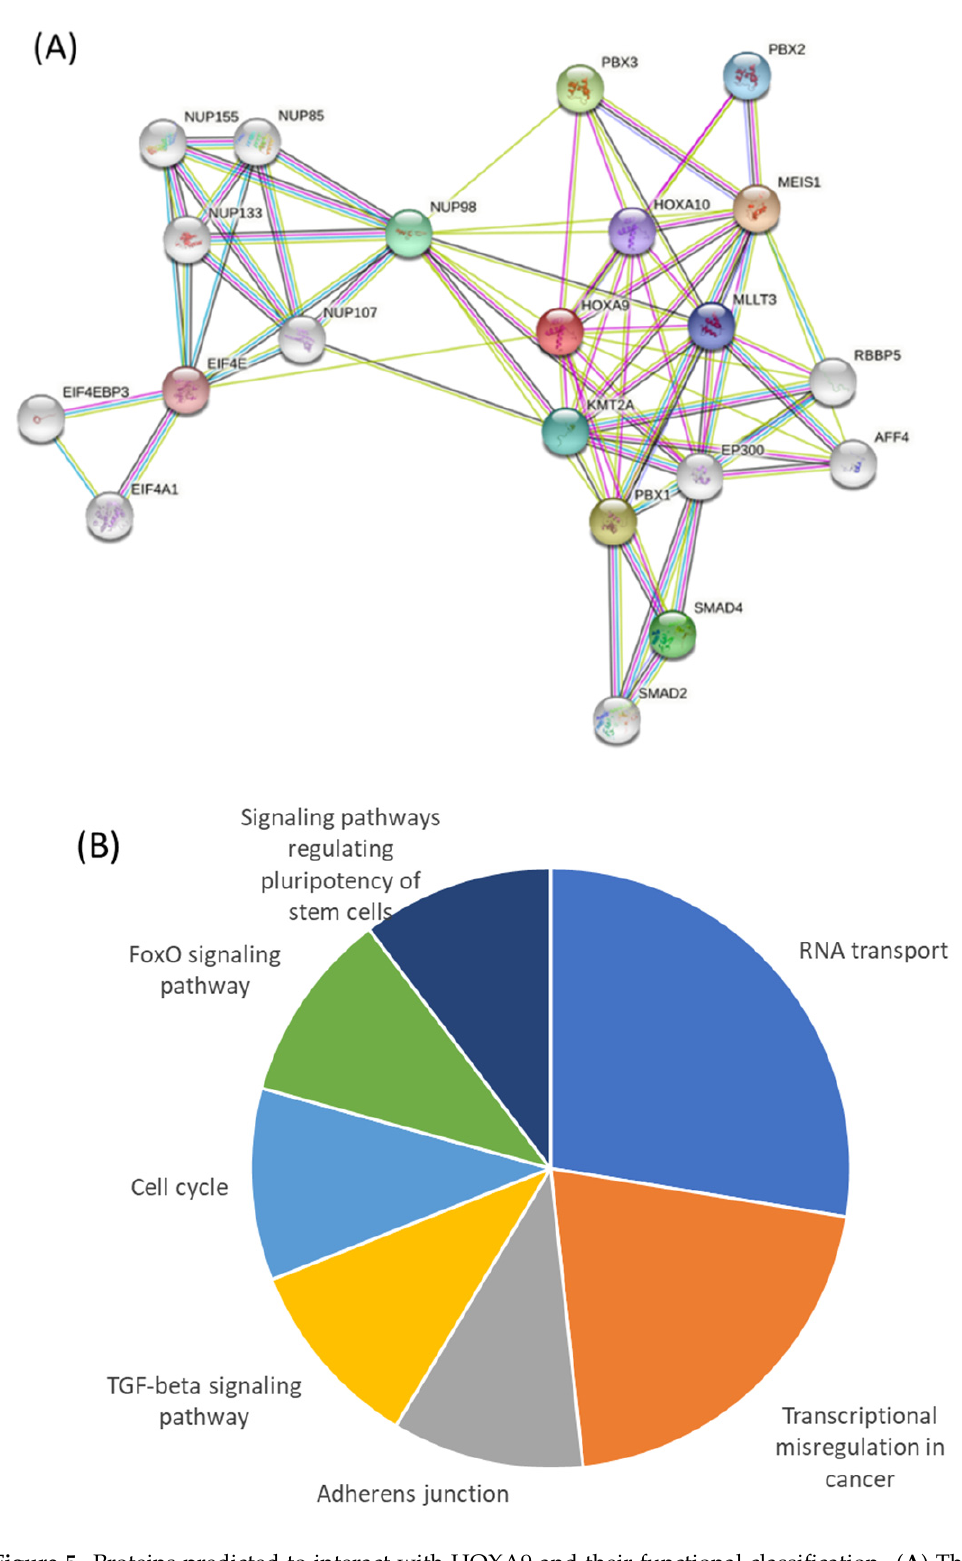
Figure 5. Proteins predicted to interact with HOXA9 and their functional classification. ( A ) The image shows the 20 proteins that were identified to have known or strongly predicted interactions with the HOXA9 protein. These proteins were organized into groups based on known functions ( B ; Table 2), using the David analysis software.